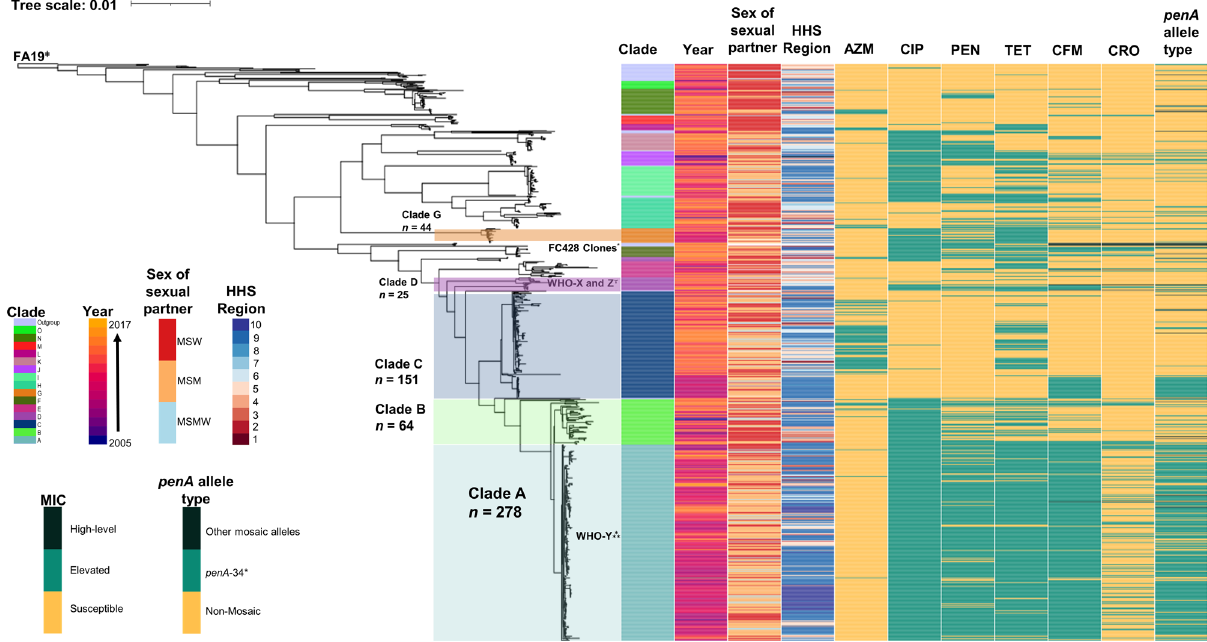
Fig. 1 Maximum likelihood tree based on core genome SNPs of 813 Neisseria gonorrhoeae strains collected from 2005 to 2017 in the United States, including clade/fastbaps cluster, year, and sex of sex partner. MSW men that have sex with women, MSM men that have sex with men, MSMW men that have sex with men and women, HHS Health and Human Services region, MIC minimum inhibitory concentration with respect to azithromycin (AZM), cipro fl oxacin (CIP), penicillin (PEN), tetracycline (TET), ce fi xime (CFM), and ceftriaxone (CRO). Highlighted clades contain isolates where we identi fi ed the majority of elevated cephalosporin MICs. The tree also includes several reference genomes: FA19 (root, ǂ ), international MLST ST1903 strains possessing the mosaic penA -60 allele (*) including strains from Japan (FC428, FC460) and Canada (47707); WHO reference strains WHO-X (H041, Japan) and WHO-Z (A8806, Australia) marked by ( ɤ ); and WHO-Y (F89, France) marked by ( ⁂ ). A summary of antimicrobial susceptibility to each respective antibiotic is shown with colors: susceptible (light orange), elevated MIC range (teal), or high-level MICs (dark green). Alleles for penA are colored based on their amino acid sequence homology to penA -34 ( ≥ 98% is a derivative allele; teal), differing mosaic penA allele (dark green), or absence of a mosaic penA